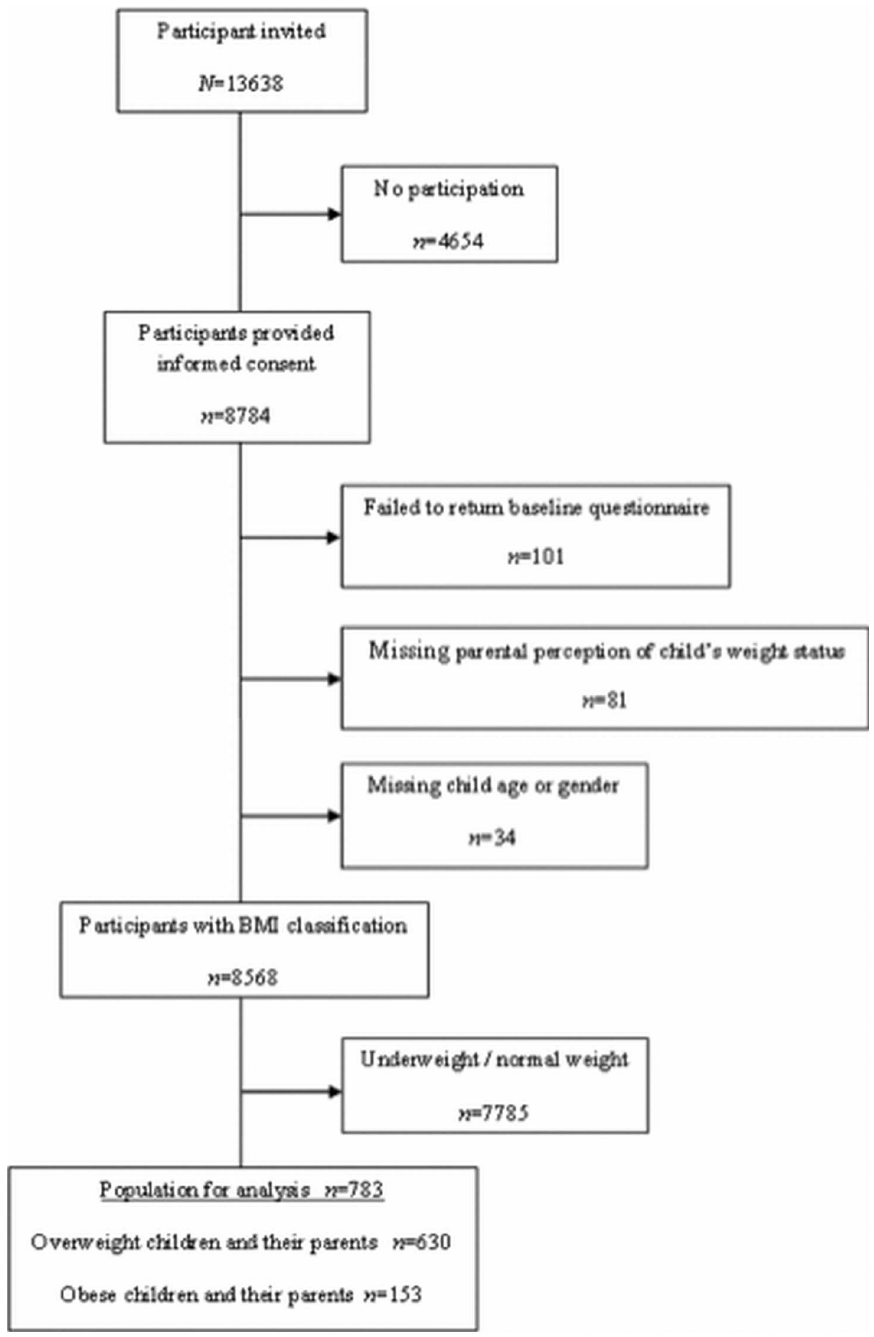
Figure 1. Flowchart.